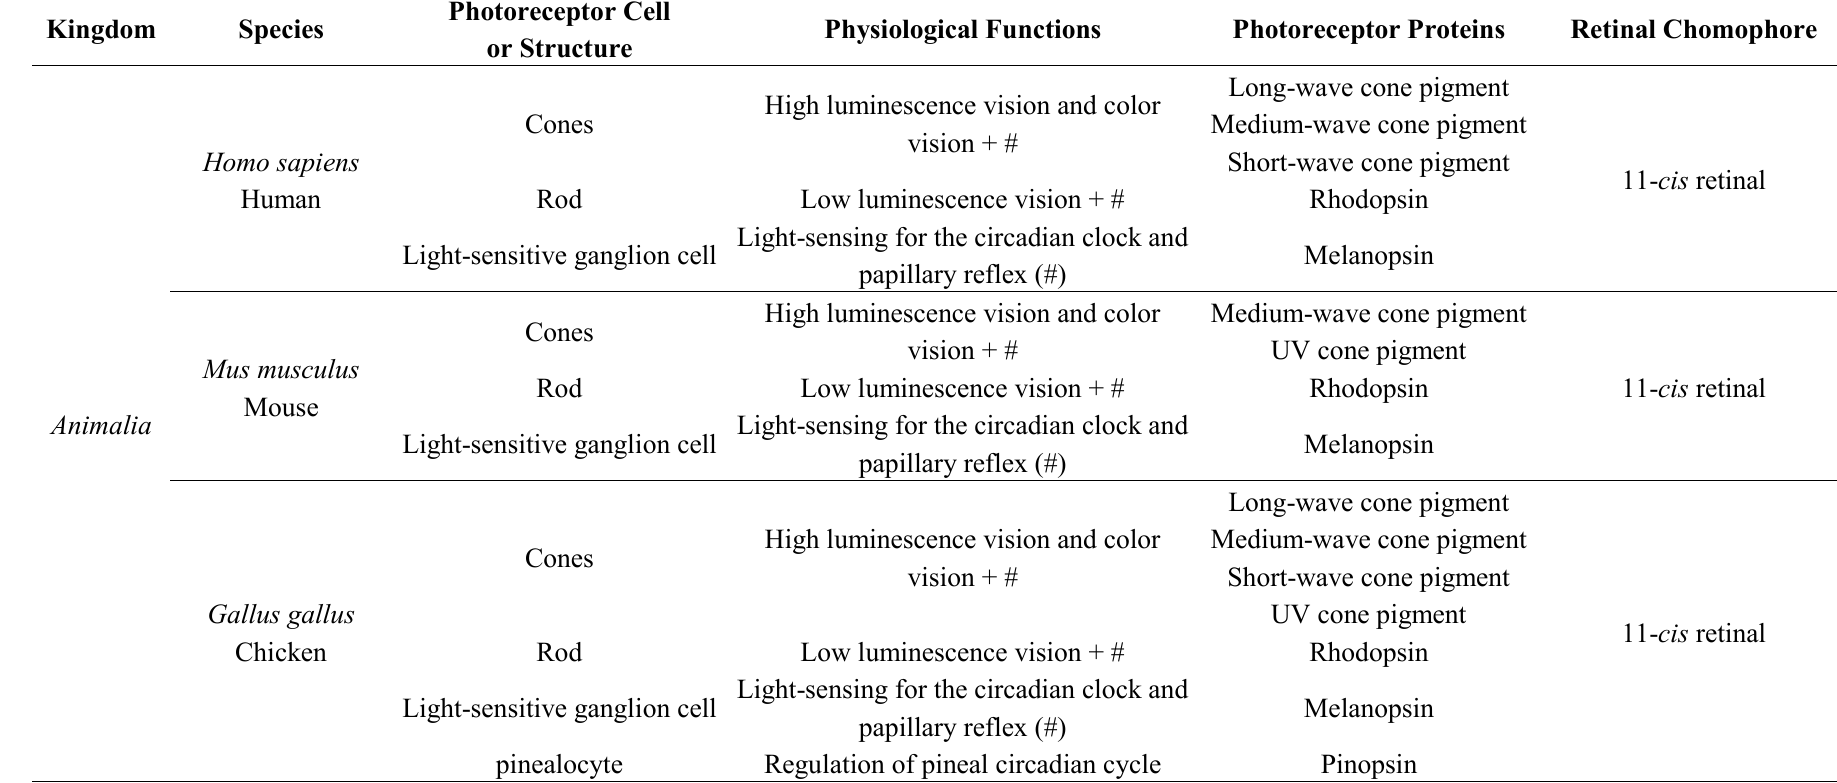
Table 1. Evolution of vitamin A-based light sensors (opsins) from bacteria to humans. The symbol # denotes the sensing of light by visual pigments for the circadian clock and pupillary reflex. Due to the tremendous diversity of opsins and space limitation, this table only depicts opsins that are representative of each kind. Opsin homologs (e.g., RGR in mammals) that function as light-dependent retinoid isomerases are not